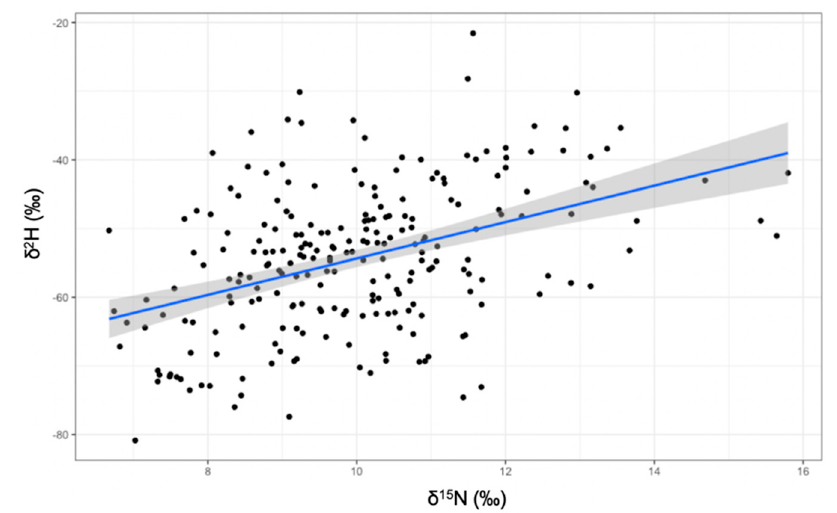
Figure 4. Significant relationship between δ 15 N and δ 2 H values ( F 1,229 = 49.14, p < 0.001).